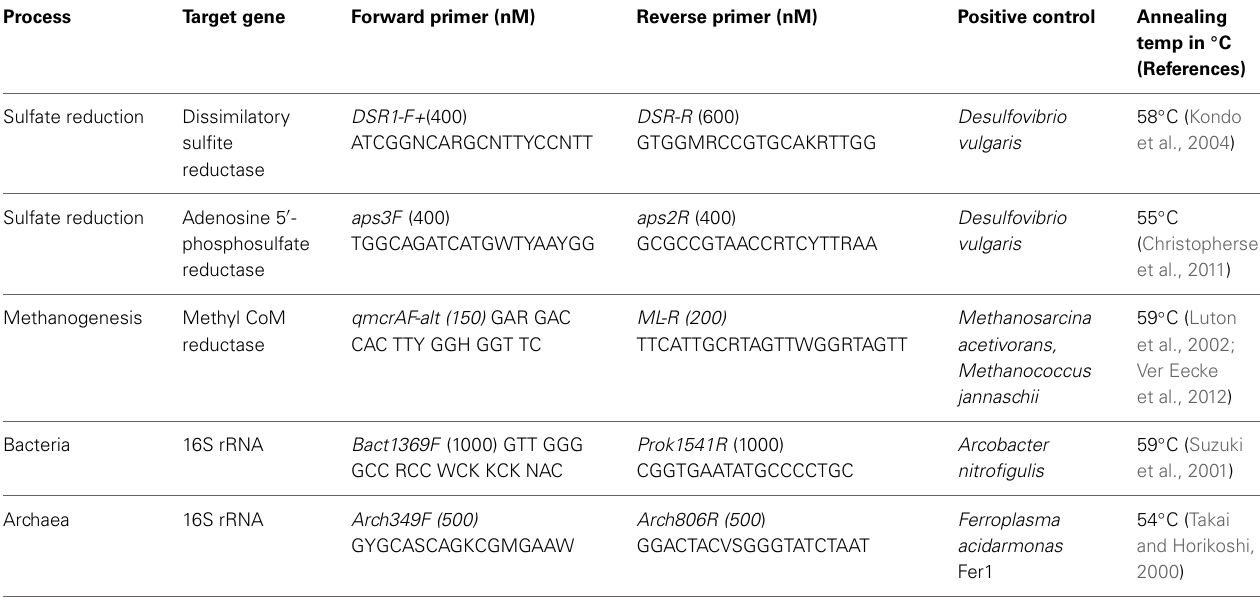
Table 1 | Primers and Conditions for quantitative PCR assays.